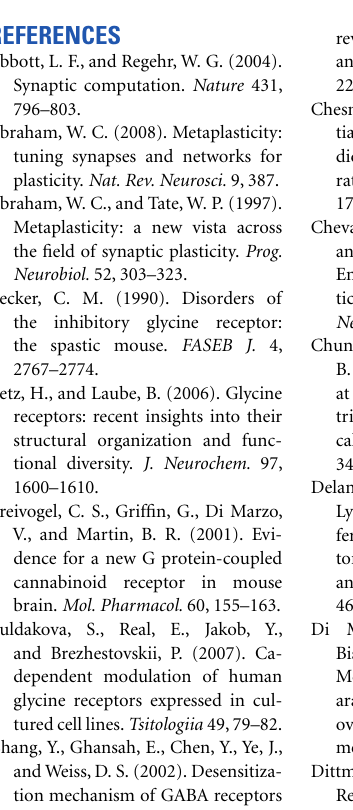
Figure S1 | Summary of the saturated effects of the modulation of human GlyR α 1H-mediated currents recorded from outside-out patches byWIN 55,212-2. (A) Superimposed representative traces of I Gly , induced by 50 μ M Gly, obtained in control, in the presence of 1 μ MWIN 55,212-2, and after wash-out of cannabinoids ( left ). ( Middle and right ) corresponding traces are normalized. (B) The averaged numbers for changes of I Gly peak ( left ), normalized charge ( middle ), and 10–90% rise time ( right ) induced byWIN 55,212-2 plotted as a fraction of the control